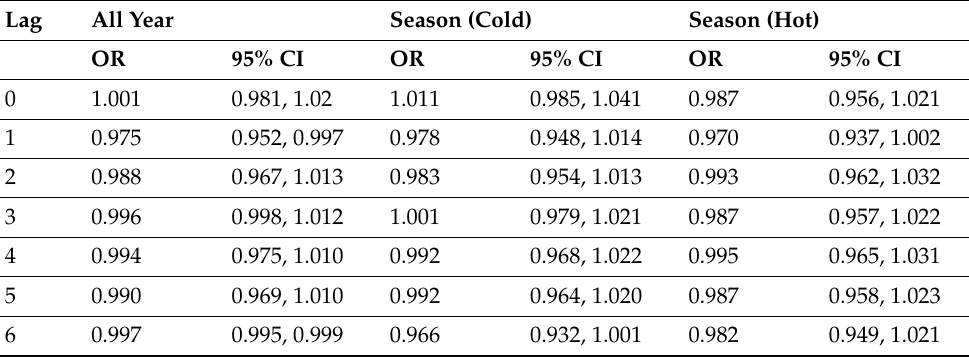
Table 4. Association of 24 h air pollution concentration of PM 10 and hospital admission for